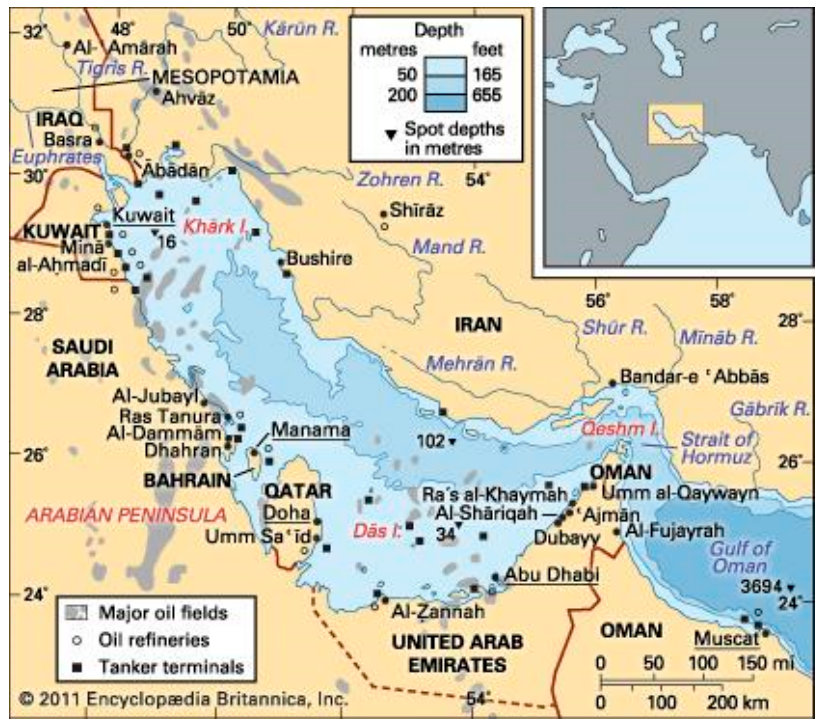
Figure 1. The Arabian Gulf (from [20]).